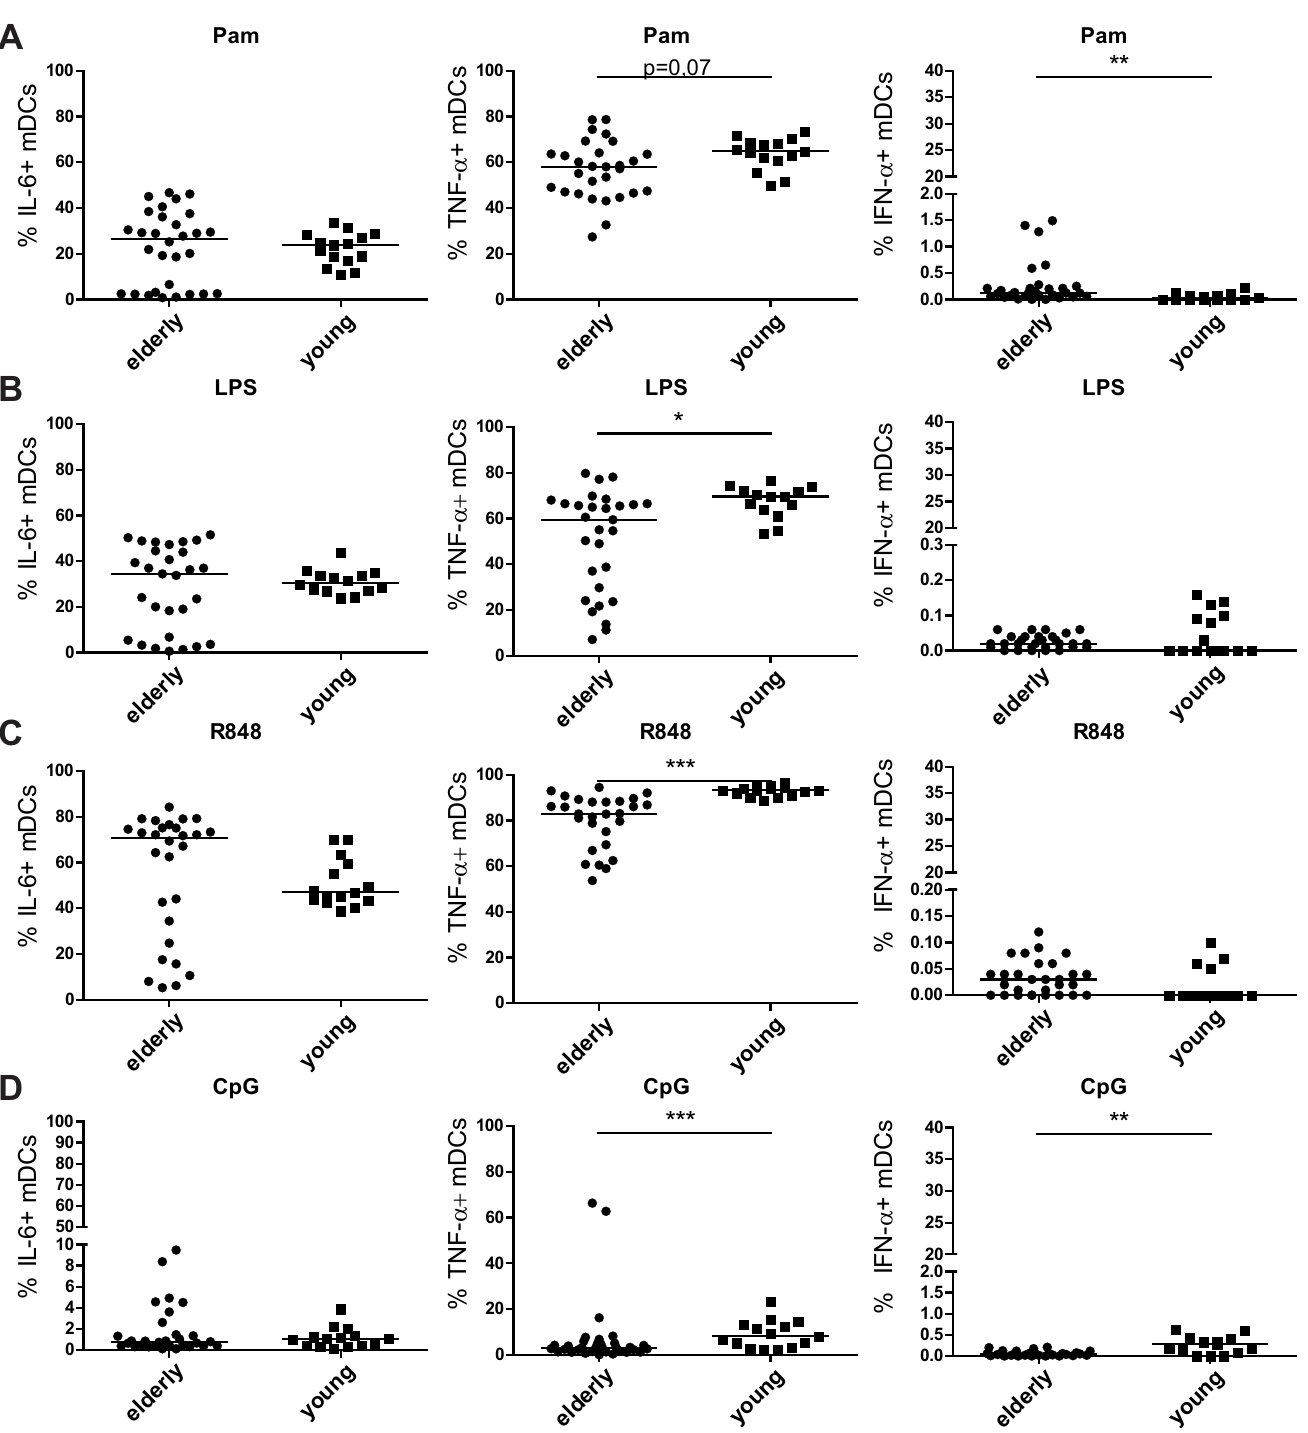
Fig 4. Intracellular cytokine production (IL-6, TNF- α and IFN- α ) of mDCs upon TLR 1/2 (A), TLR 4 (B), TLR 7/8 (C) and TLR 9 (D) stimulation in young versus older adults. Data shown as dot plots with median, every dot represents a donor, outliers with > 2SD based on transformed data were removed. Elderly n = 30; young n = 15 donors. Statistics were done with logit or rank transformed data using MANOVA per TLR stimulation with a pairwise comparison and a bonferroni correction. � p < 0.05; �� p < 0.01; ��� p <